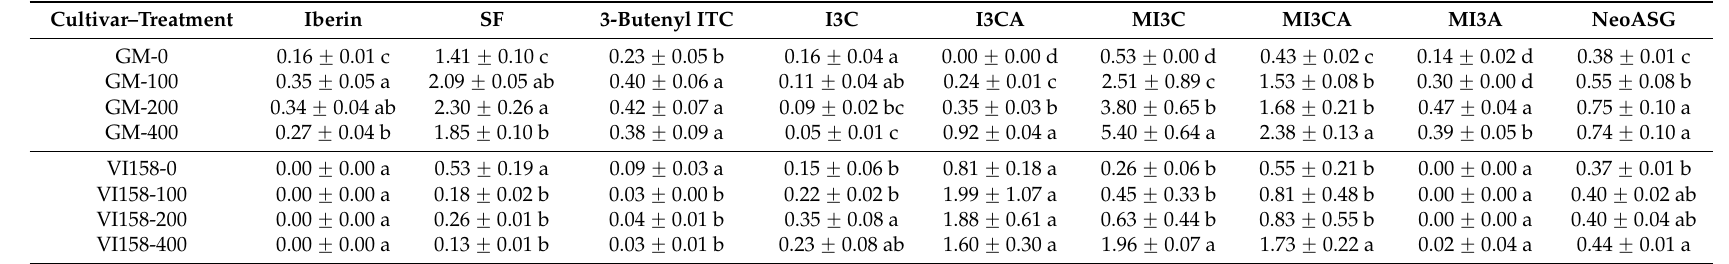
Table 2. Glucosinolate hydrolysis product profiles ( µ M/g DW) of two broccoli cultivars treated with different jasmonate (JA) concentrations; Different letters from right side of values indicate differences between treatment/cultivar combinations for a given glucosinolate hydrolysis product according to Fisher’s LSD tests ( p = 0.05); Abbreviations: GM = Green Magic; ITC = isothiocyanate; I3C = indole-3-carbinol; I3CA = indole-3-carboxaldehyde; MI3C = 1-methoxyindole-3-carbinol; MI3CA = 1-methoxyindole-3-carboxaldehyde; MI3A = 1-methoxyindole-3-acetonitrile; NeoASG = neoascorbigen; SF =